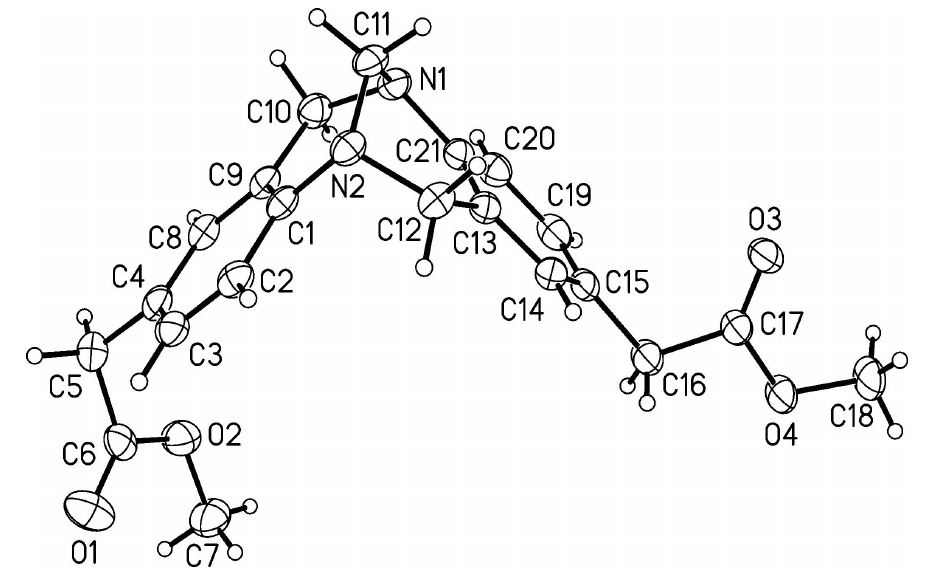
Figure 1 View of one of the two unique molecules present in the asymmetric unit of (I), with the atom-numbering scheme. Displacement ellipsoids are drawn at the 50% probability level.